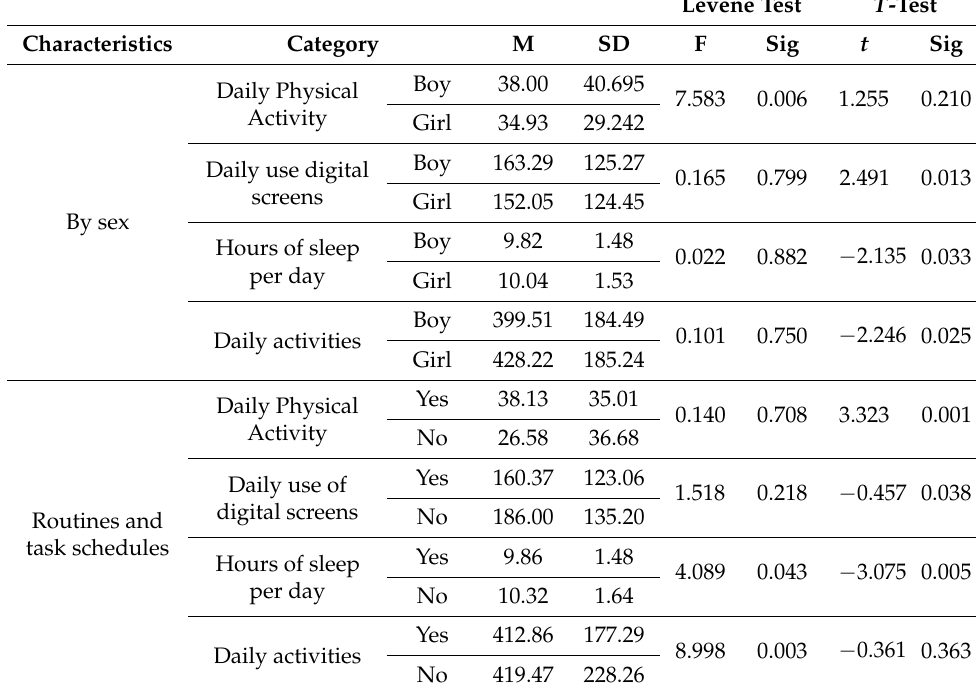
Table 3. Sex and the establishment of routine in reference to children’s healthy and daily behaviours.